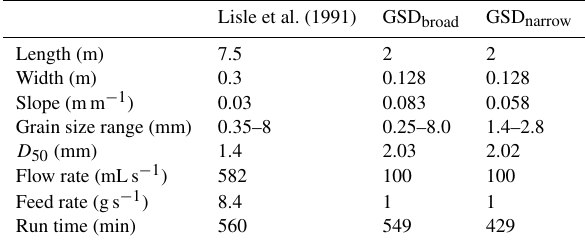
Table 9. Flume dimensions and run conditions for Lisle et al. (1991) and the two 100L experiments included